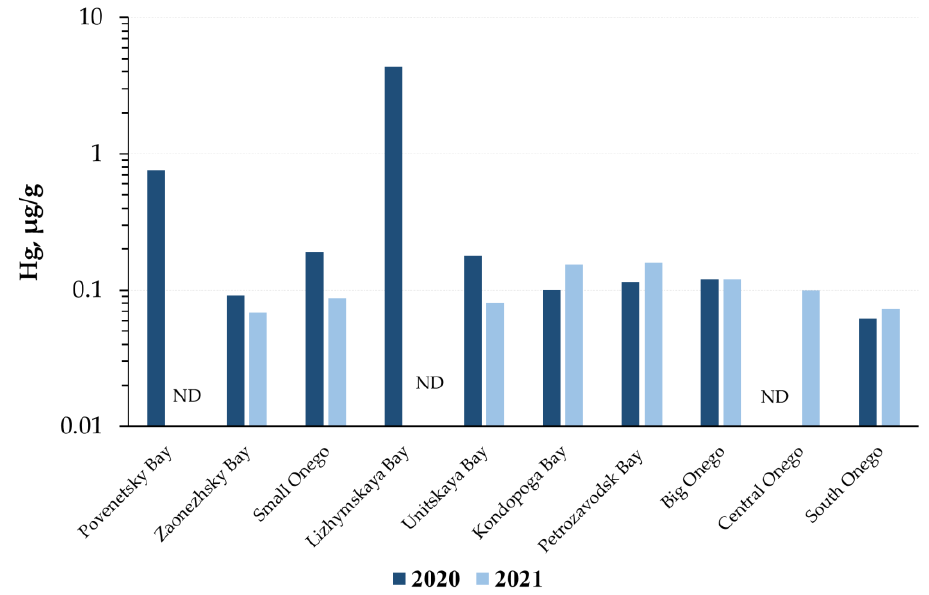
Figure 3. Mercury content in the sedimentation traps material from the different areas of Lake Onego in 2020 and 2021. ND- no data available. Table 2. Mercury content in the components of the Lake Onego ecosystem.